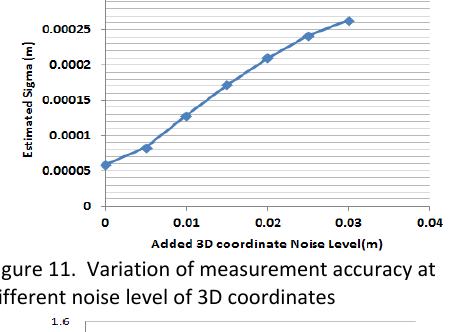
Figure 11. Variation of measurement accuracy at different noise level of 3D coordinates